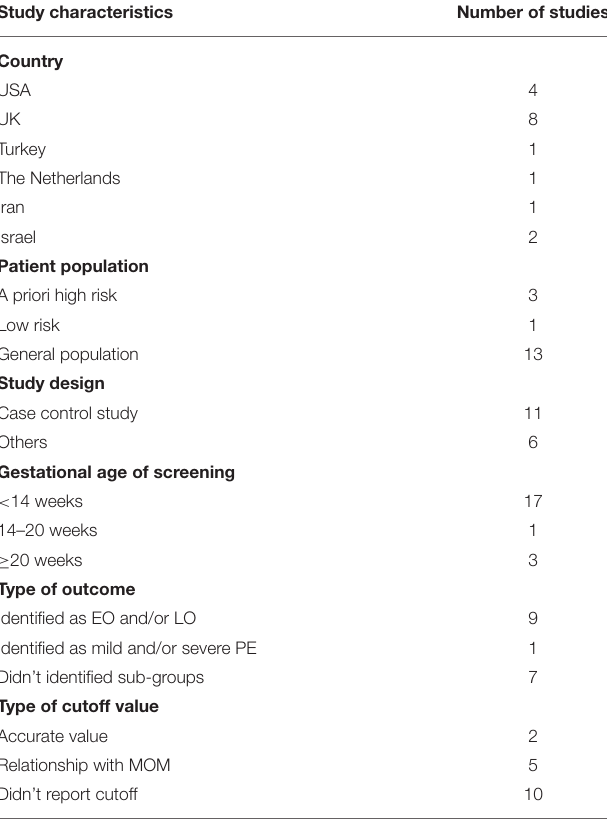
TABLE 2 | Overview of study